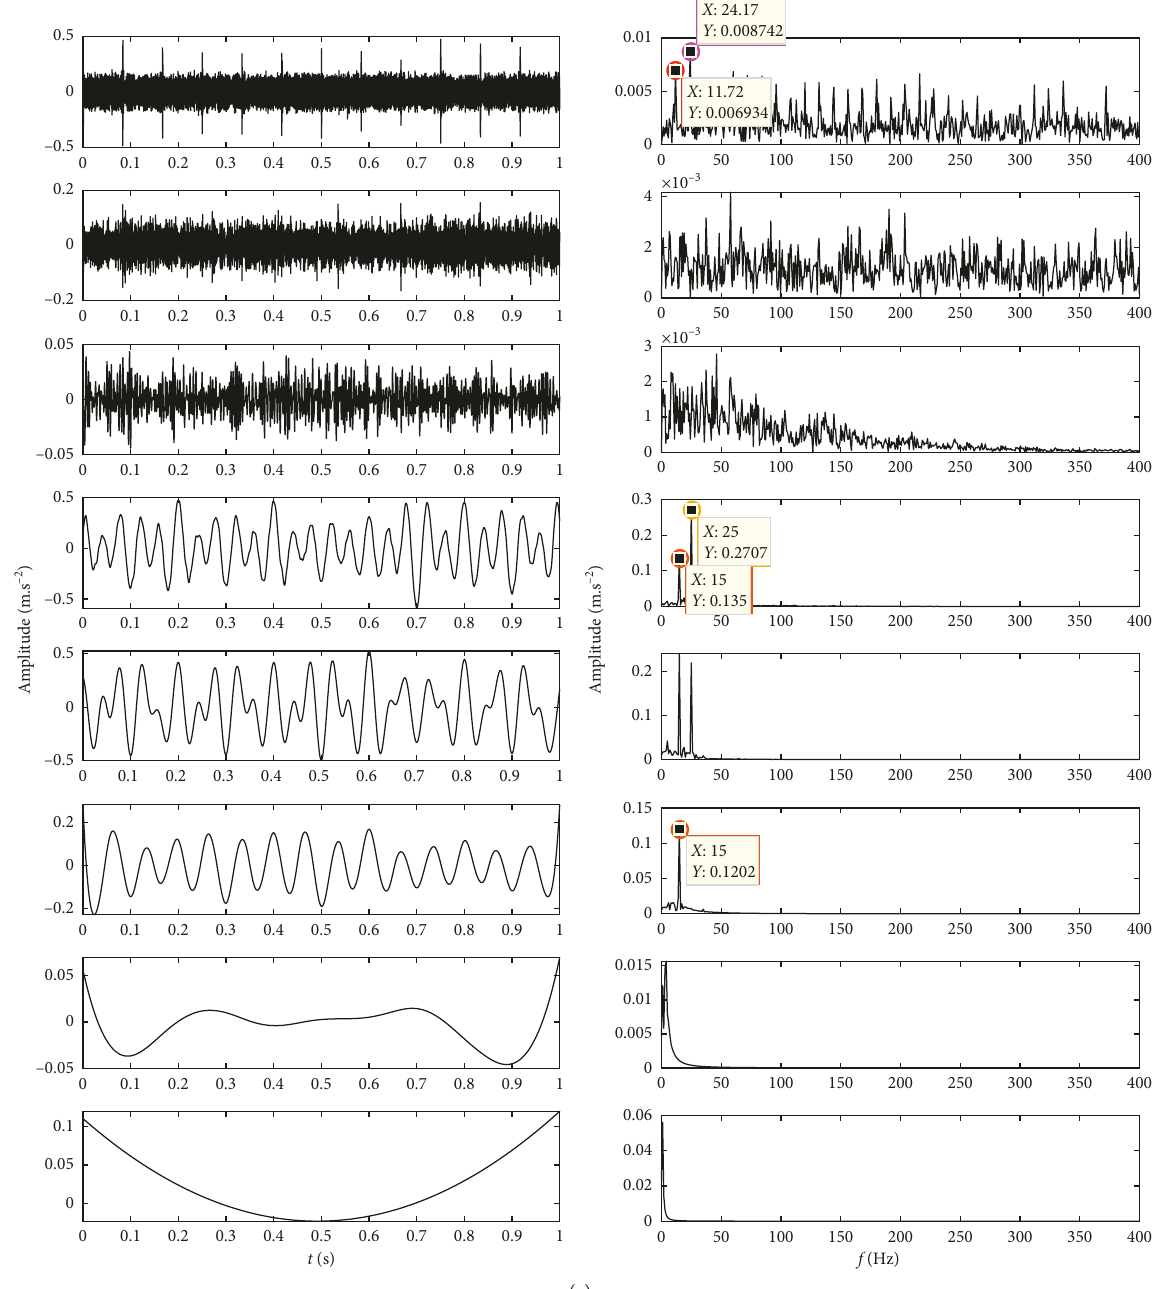
Figure 5: The characteristic components and corresponding marginal spectrum of the simulation signal based on (a) VMD, (b) LMD,